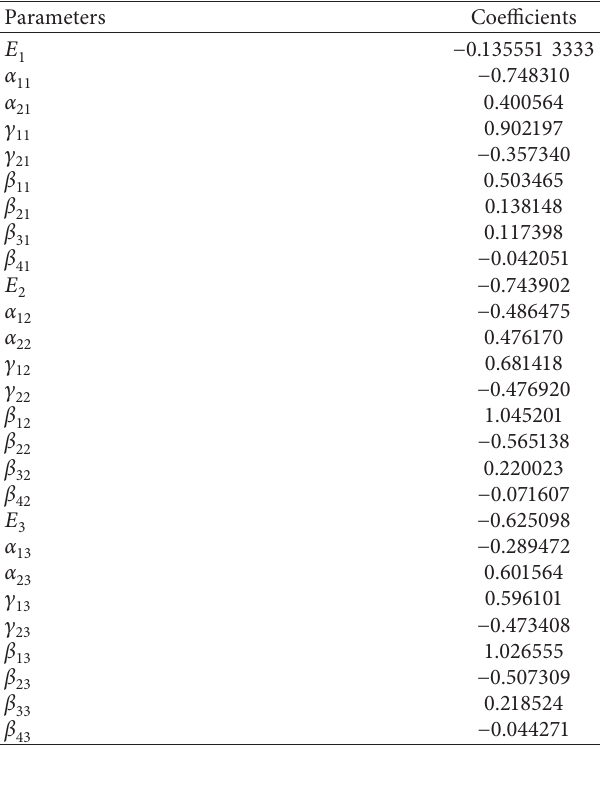
Table 10: The estimated parameters of the fuzzy-EGARCH-ANN model on the first 800 simulated data points.